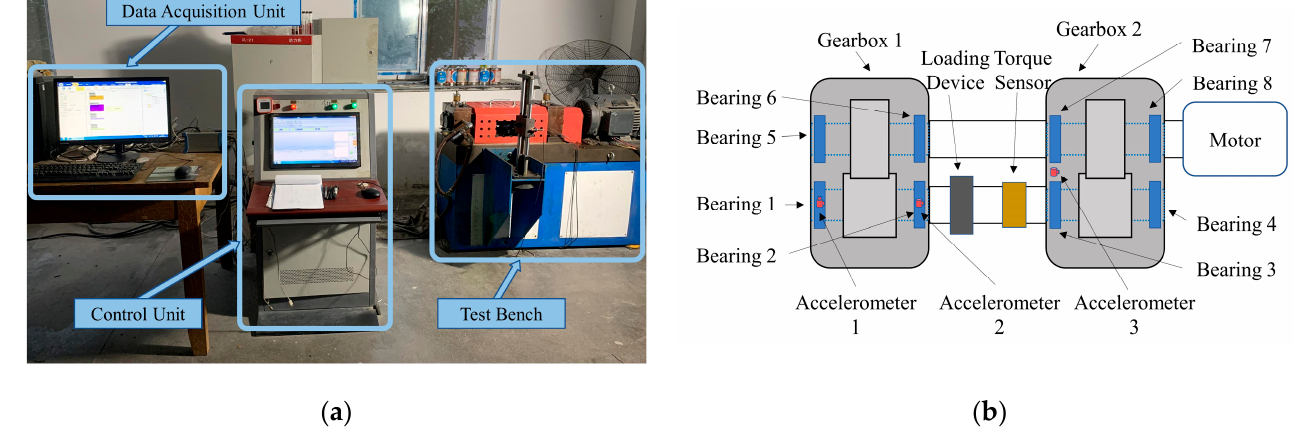
Figure 11. Experiment setup: ( a ) experiment equipment, ( b ) detailed schematic diagram of the test bench.